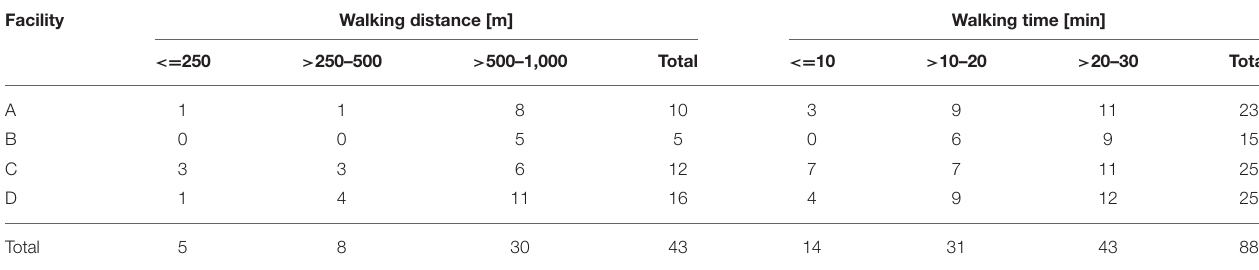
TABLE 2 | Supply in terms of number of urban green spaces classified by distance and walking time (without barriers). Facility